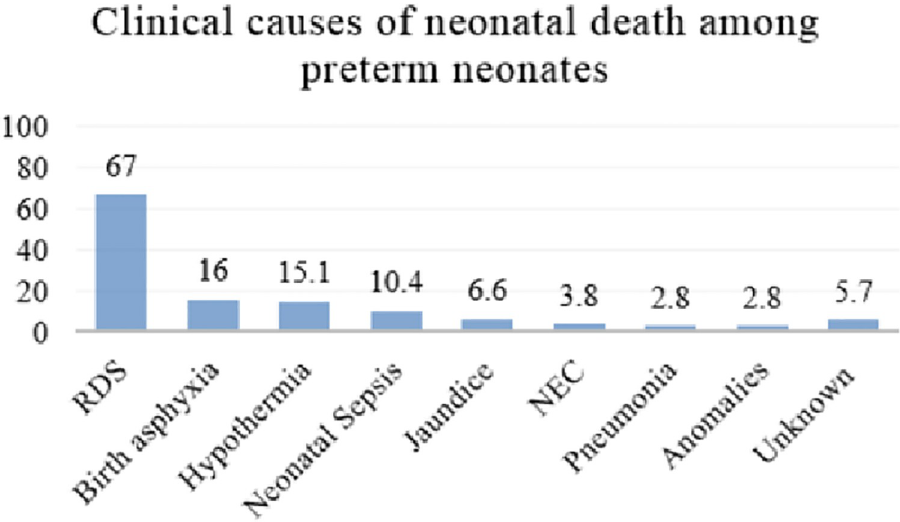
Fig 3. Bar chart showing the clinical causes of death among preterm neonates born at MRRH from October, 2019 to September, 2020 (n = 106). RDS—respiratory distress syndrome; NEC—necrotizing enterocolitis.